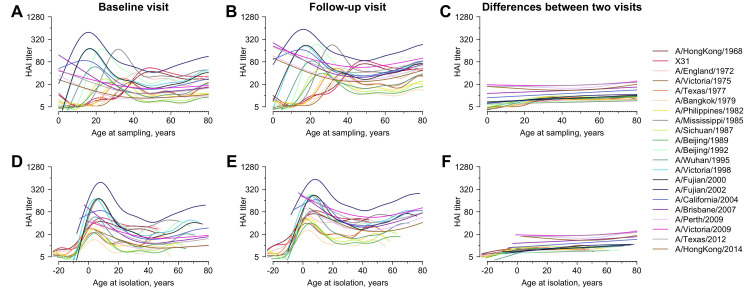
Age and HAI titer against individual H3N2 strain.Lines are the predicted mean HAI titer fitted from general additive model (GAM) using age at sampling (panel A to C) and age at isolation (panel D to F) as predictor, respectively. We fitted separate GAMs for HAI titers measured for serum collected from baseline (panel A and D), serum collected in follow-up visit (panel B and E) and the differences between two visits (panel C and F).